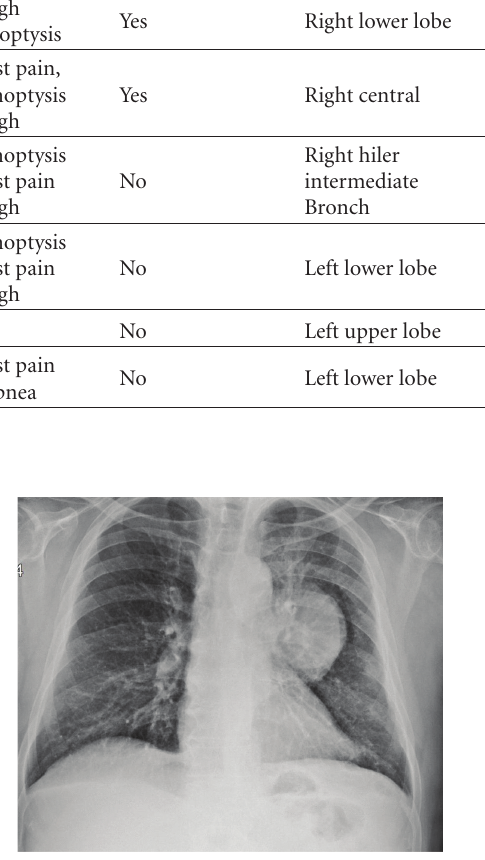
Figure 1: Chest X-ray of a patient showing a mass lesion located left hiler